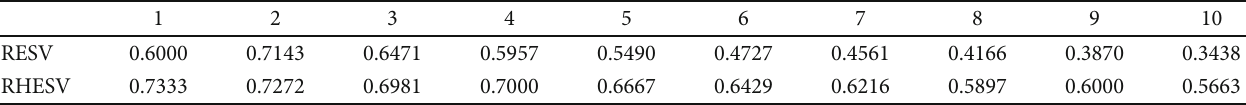
Table 1: The relative lifting rate of three targets.